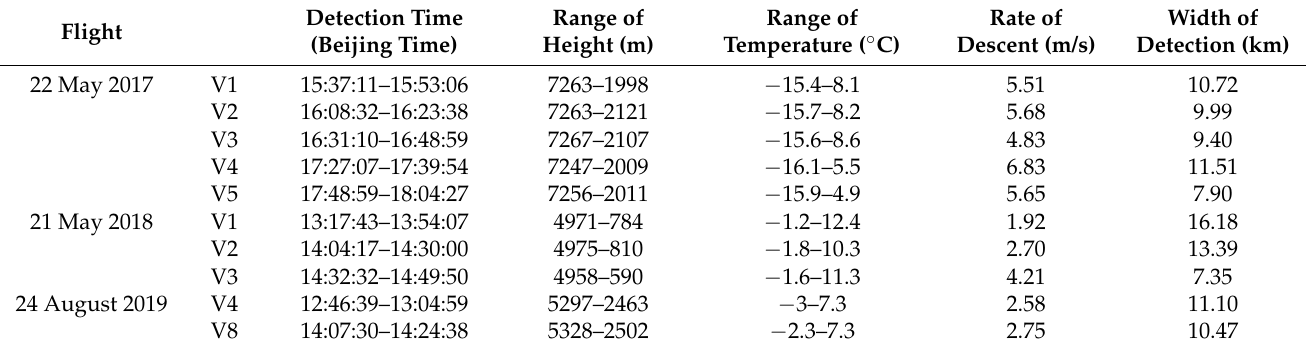
Figure 1. Flight track of the 3 aircraft (from left to right is 22 May 2017, 21 May 2018, and 24 August 2019). Table 1. Details of the observation